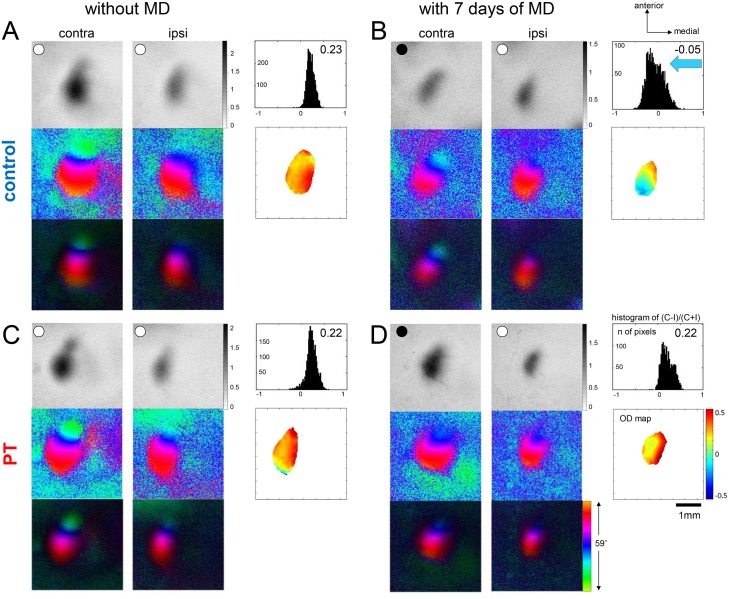
A cortical lesion in M2 impairs OD-plasticity in the visual cortex of the lesioned hemisphere.Optically recorded activity maps of the contralateral (contra) and ipsilateral (ipsi) eye in the binocular region of mouse primary visual cortex (V1) in sham-treated control mice (A, B) and in mice with a PT-lesion in M2 of the recorded hemisphere (C, D). Activity maps without MD are illustrated in the left column (A, C), maps after MD in the right column (B, D). Gray-scale coded response-magnitude maps and their quantification (top), and color-coded phase and polar maps of retinotopy (middle, bottom) are illustrated. The magnitude of the optical responses is illustrated as fractional change in reflection x10-4. For each experiment, the histogram of OD-scores (upper right), the OD-index (ODI), and the corresponding 2D OD-maps (ODI values are color-coded: red represents positive, blue negative values) are included. Note that without MD, activity patches evoked by stimulation of the contralateral eye were consistently darker than those after stimulation of the ipsilateral eye, 2D OD-maps display warm colors, and the average ODI is positive, indicating contralateral dominance (A, C). In contrast, MD for 7 days in control- (B) but not PT-animals (D) induced an OD-shift toward the open (ipsilateral) eye: the activity map of the ipsilateral eye was even darker than after contralateral (deprived) eye stimulation (black circle indicates MD eye), the histogram of OD-scores shifted to the left (blue arrow in B), the ODI was negative, and colder colors prevailed in the OD-map. In contrast, in PT-animals with MD (D), activity maps of the deprived (contra) eye remained darker than those of the open eye, the histogram of OD-scores and the average ODI were essentially unchanged and warm colors still prevailed in the OD-map.